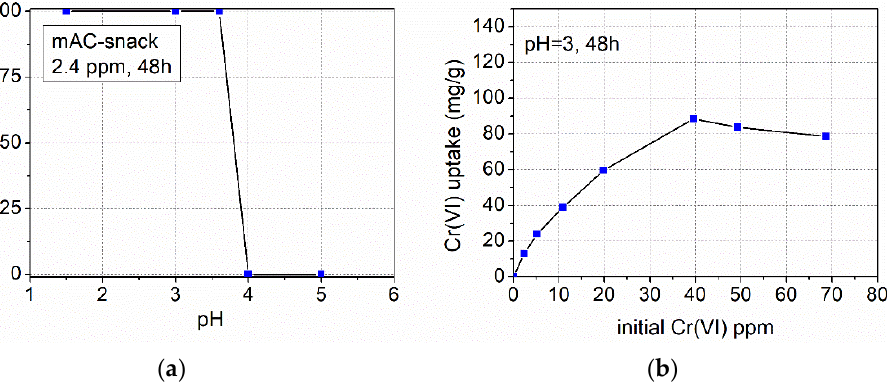
Figure 7. ( a ) Effect of pH value upon maximum removal capacity of Cr(VI) from aqueous solutions. ( b ) Effect of initial Cr(VI) concentration in aqueous solutions upon the maximum uptake capacity of mAC-snack material.